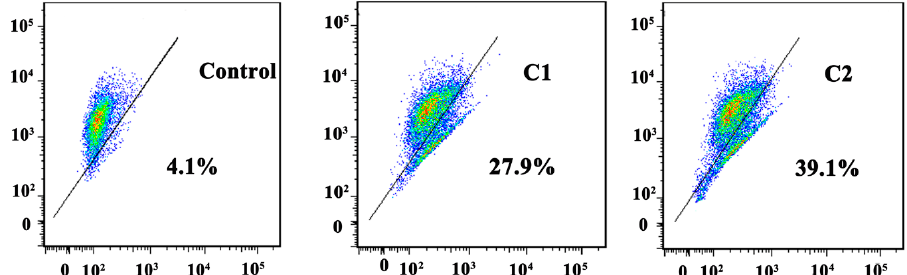
Figure 6. Assay of the A-549 cells’ mitochondrial membrane potential with JC-1 fluorescence probe staining compared with untreated cells.